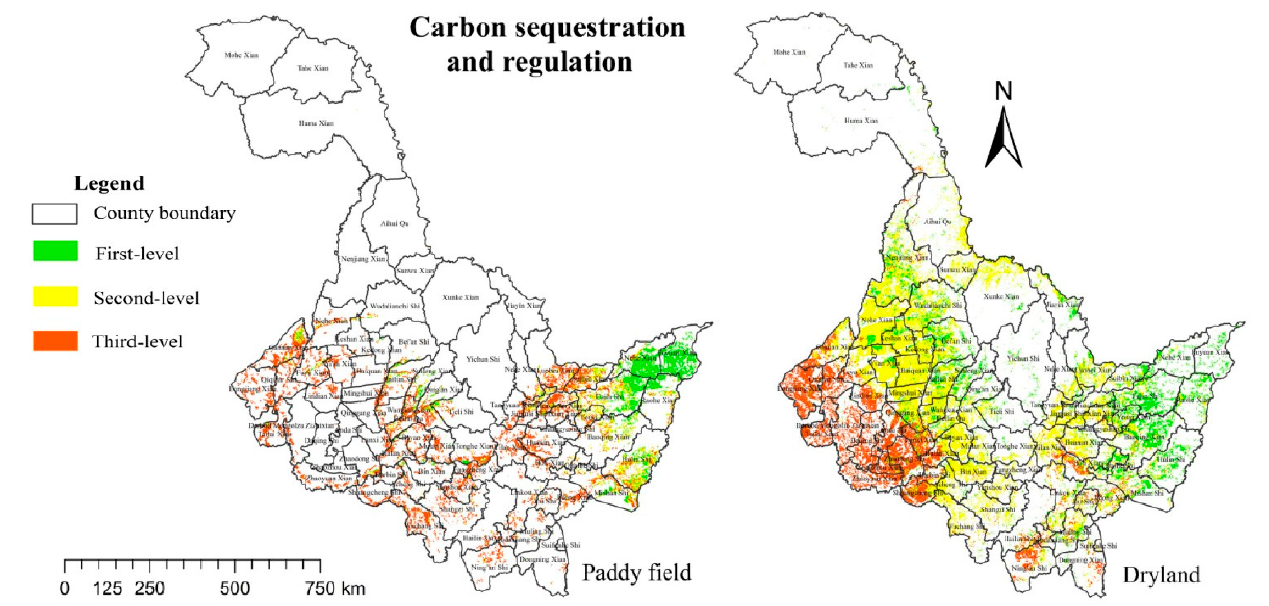
Figure 9. The grade of soil carbon sequestration and regulation function in paddy fields and drylands.